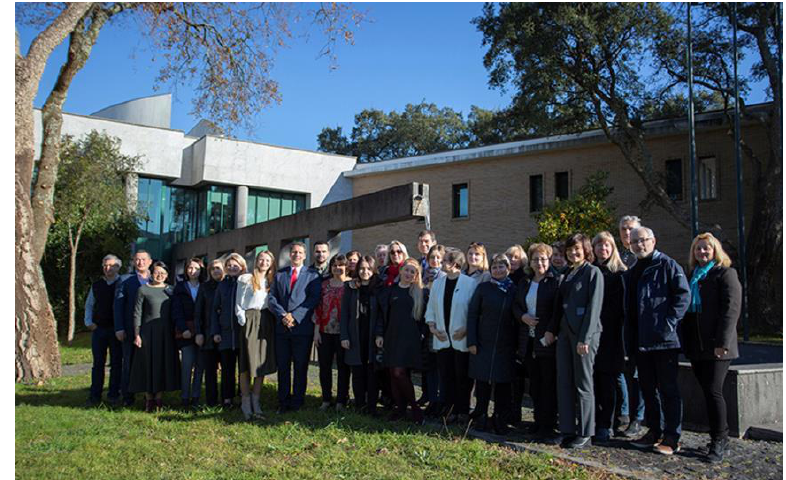
Fig. 2. Initial meeting of ENTER project, January